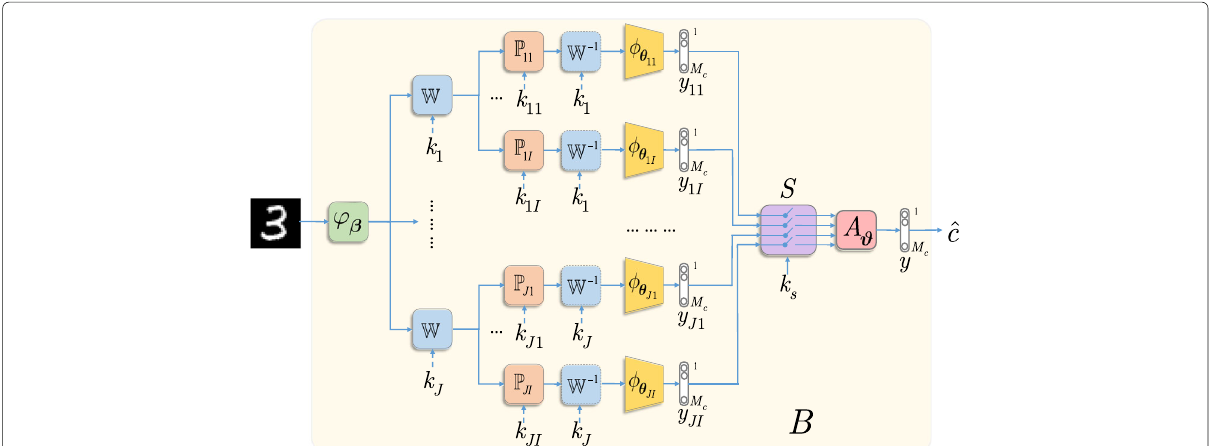
Fig. 6 Generalized diagram of the proposed multi-channel system with the